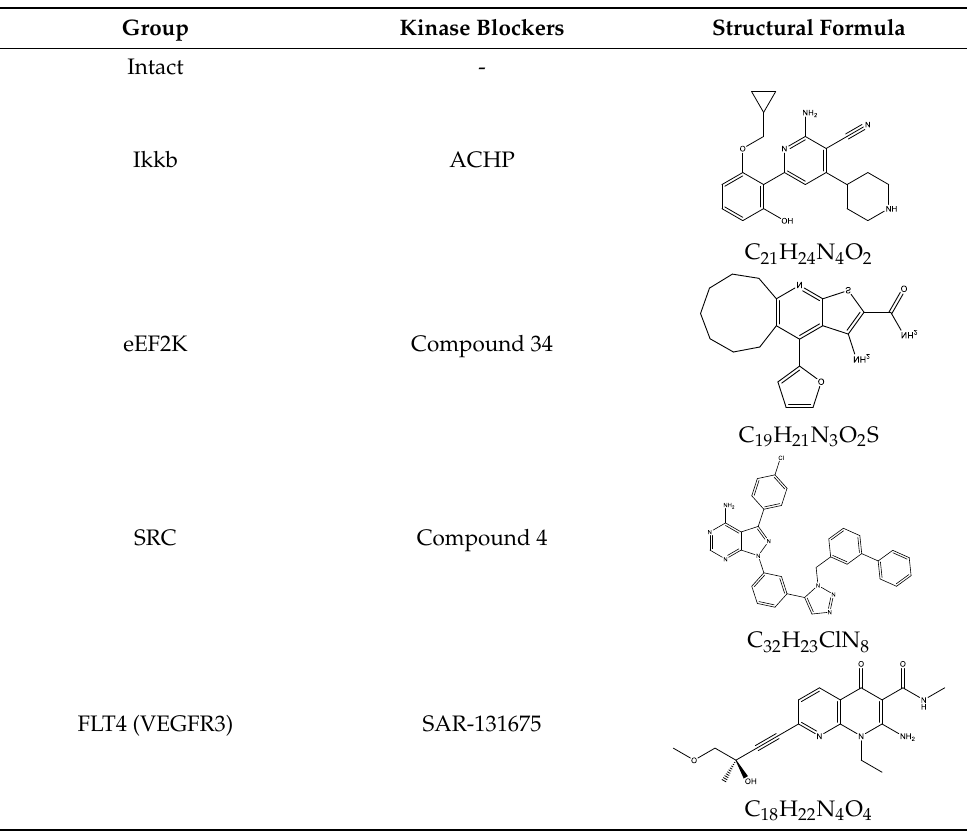
Table 5. The chemical structure of the kinase inhibitors.